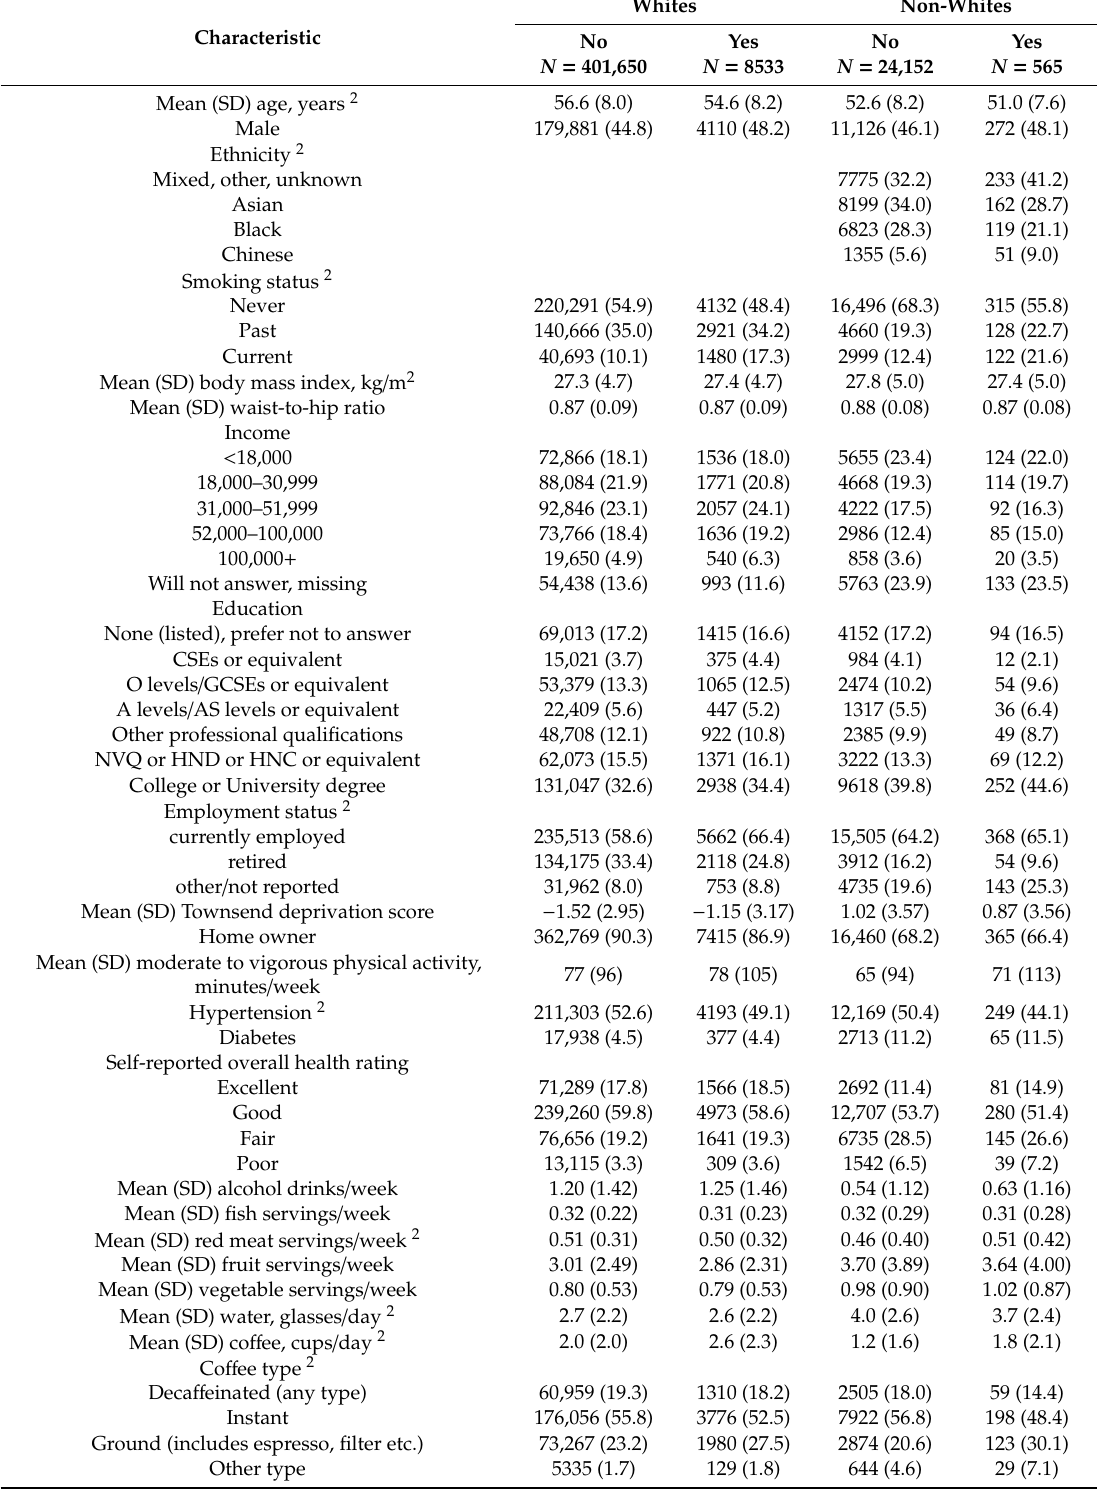
Table 1. Baseline characteristics of UK Biobank participants according to recent ca ff eine drinking status 1 .